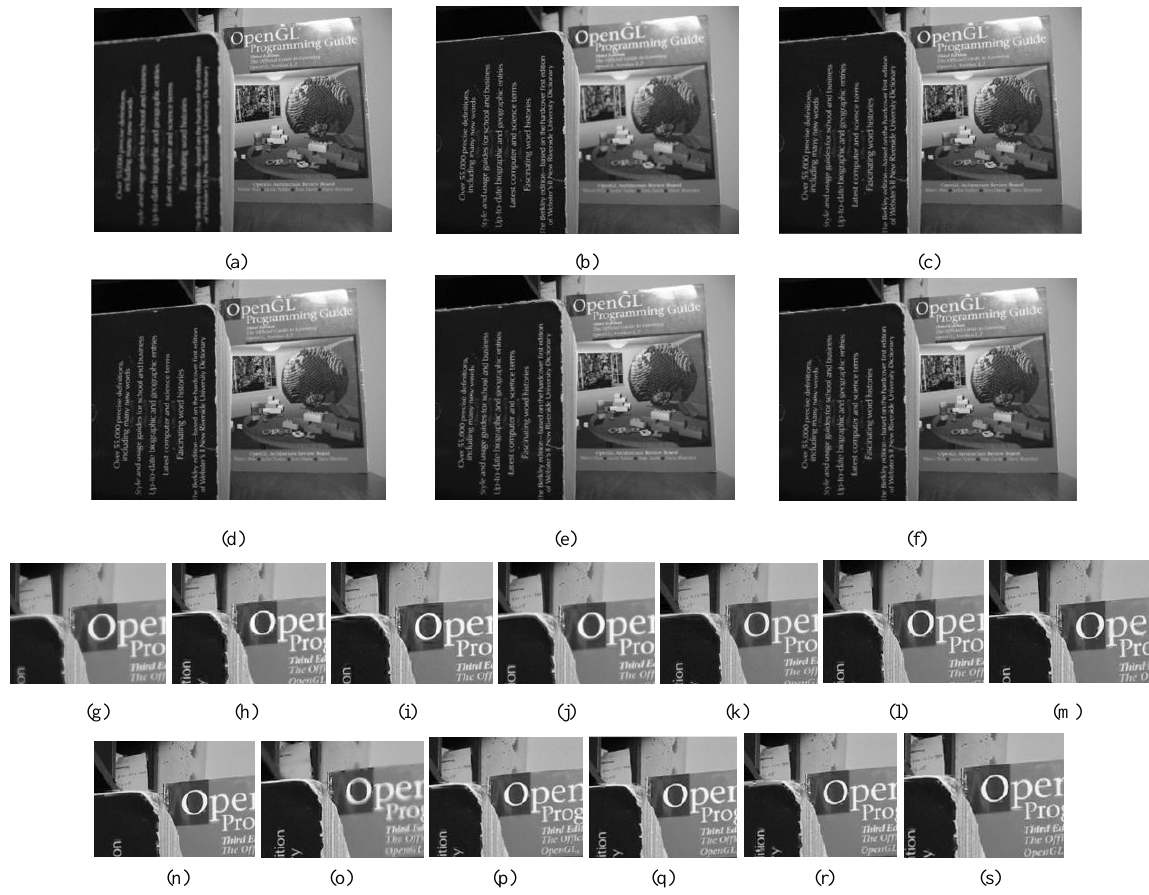
Figure 5. Source images “Book” and fusion results. (a) First source image with focus on the right. (b) Second source image with focus on the left. (c) DCT + EOL (proposed) result. (d) DCT+VOL(proposed). (e) DCT+Corr(proposed). (f) DCT+Eng_Corr (proposed). (g), (h), (i), (j), (k), (l), (m), (n), (o), (p), (q), (r), and (s) are the local magnified versions of DCT+Average, DCT+Contrast, DWT, SIDWT, DCHWT, DCT+Variance, DCT+Ac_Max, DCT+SF, DCT+SML, DCT+EOL(proposed), DCT+VOL(proposed), DCT+Corr(proposed), and DCT+Eng_Corr (proposed), respectively.